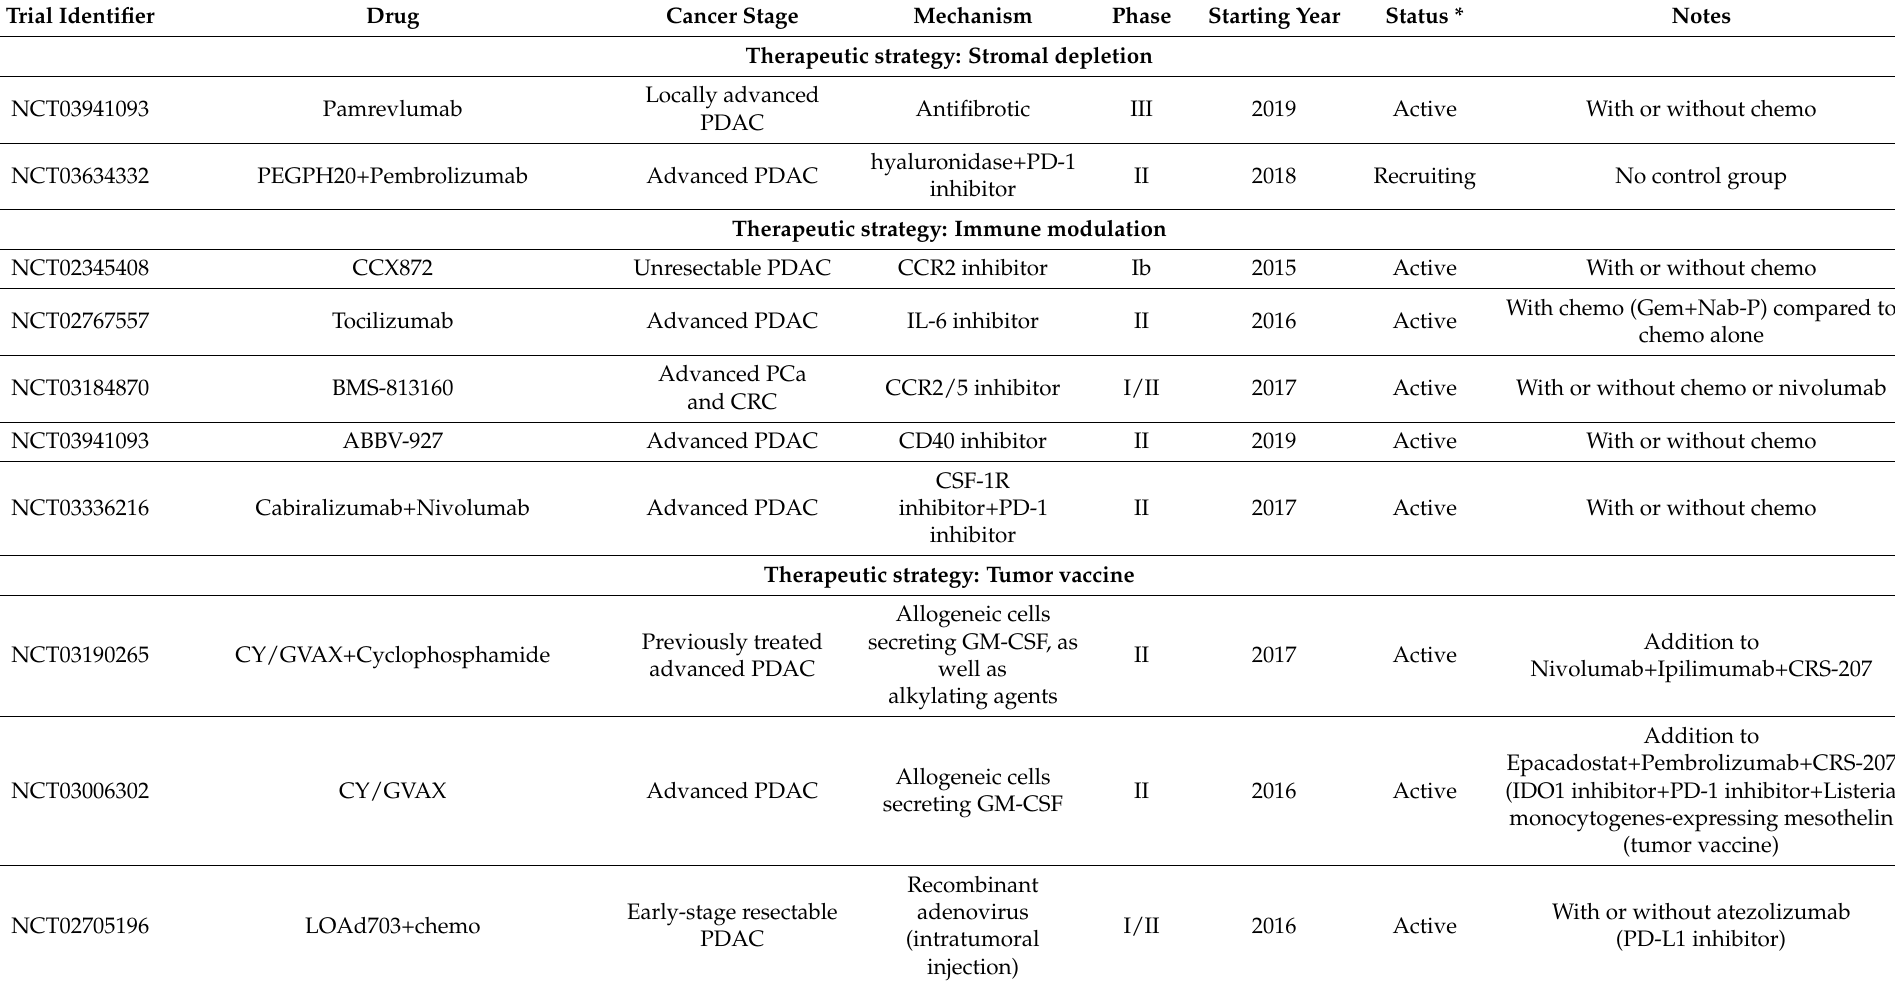
Table 1. Ongoing clinical trials involving potential therapies against pancreatic cancer that target the tumor